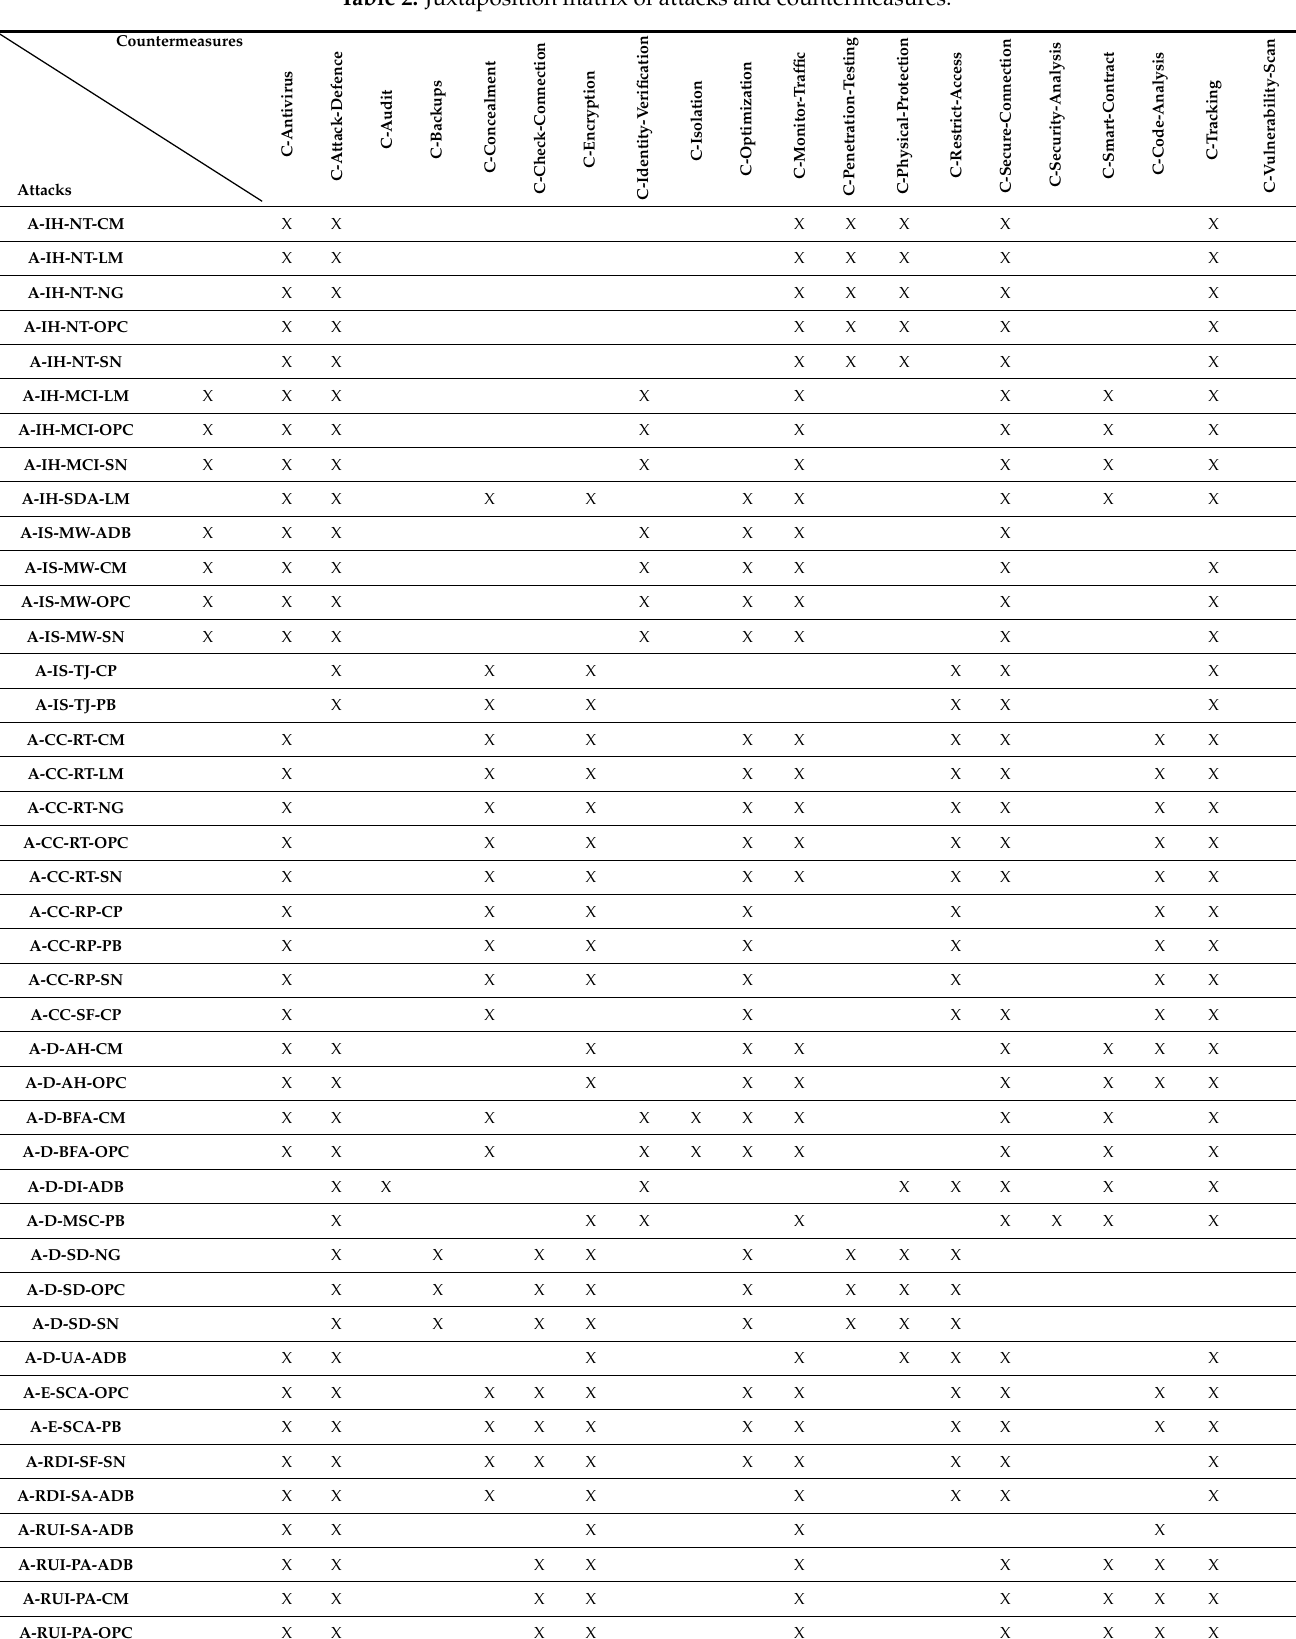
Table 2. Juxtaposition matrix of attacks and